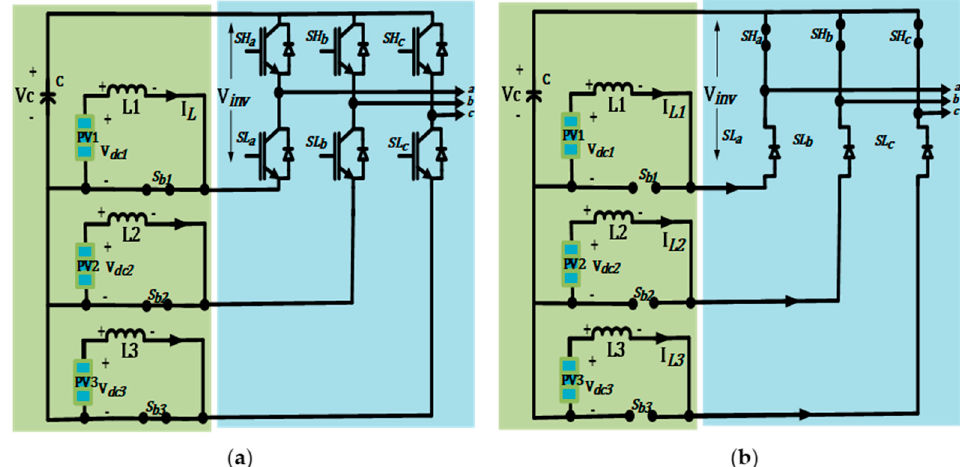
Figure 4. The simplified equivalent circuit diagram of the proposed multi-input inverter; ( a ) Mode 1: inductor charging; ( b ) Mode 2: inductor discharging.